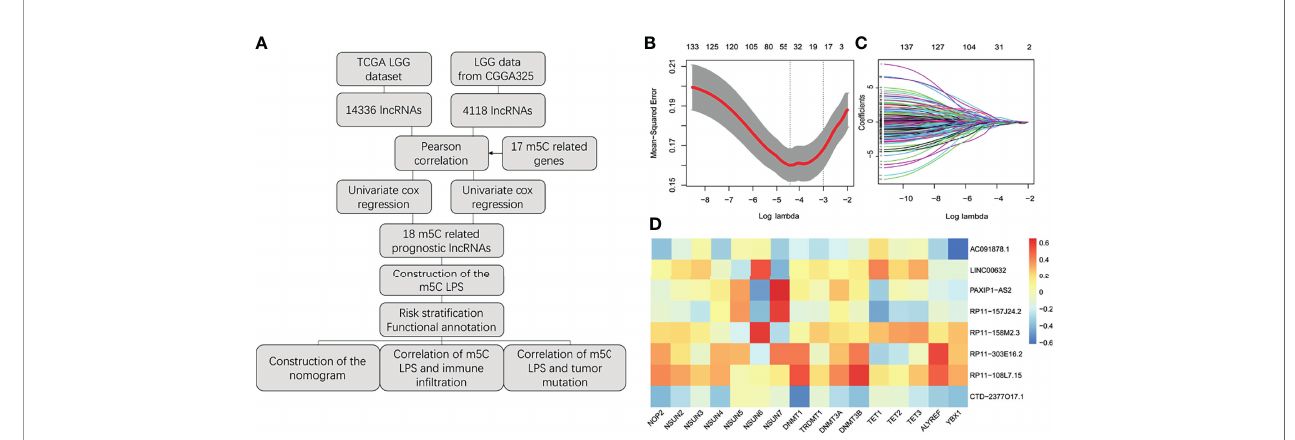
FIGURE 1 | Construction of the m5C related lncRNAs prognostic signature. (A) Study fl ow chart. (B, C) Lasso regression analysis for m5C LPS construction. (D) Heatmap of the correlations of m5C-related lncRNAs and